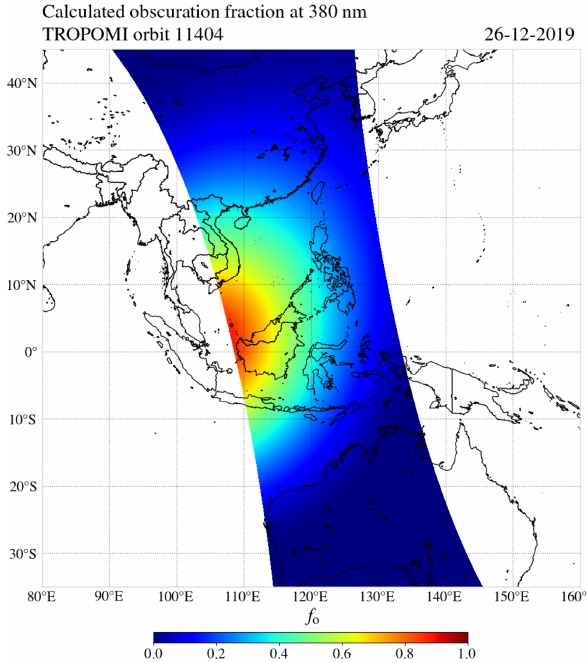
Figure 9. Moon shadow types at the instant of the greatest eclipse during the annular solar eclipse on 26 December 2019. Figure 10. The calculated eclipse obscuration fraction at 380nm for the ground pixels in TROPOMI orbit